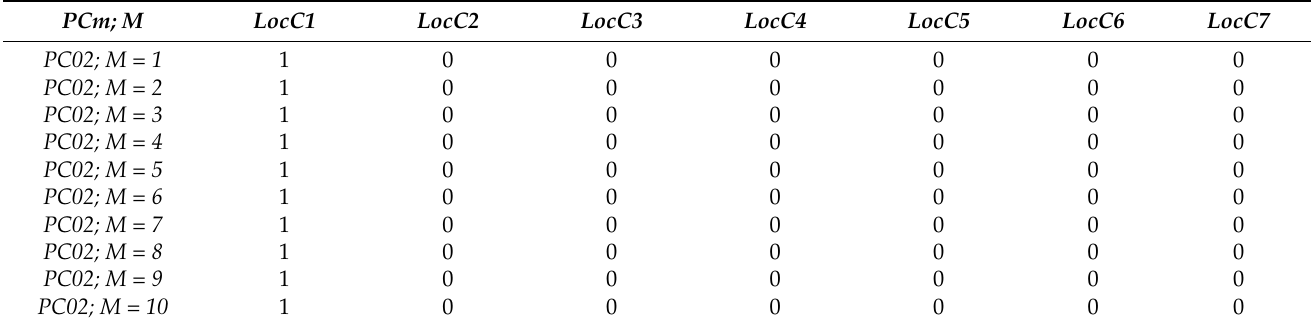
Table 7. Probability of designating a LocCn locator node as the closest one to the wristband placed at the PC02 location with different window widths M